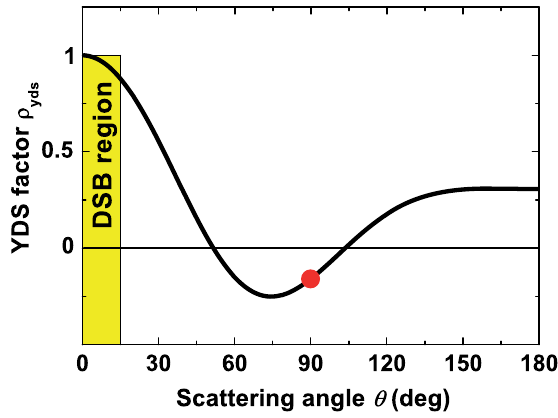
[Eq. (6)] on yds π = 2 Þ ≈ − 0 . 16 (circle) yds ð